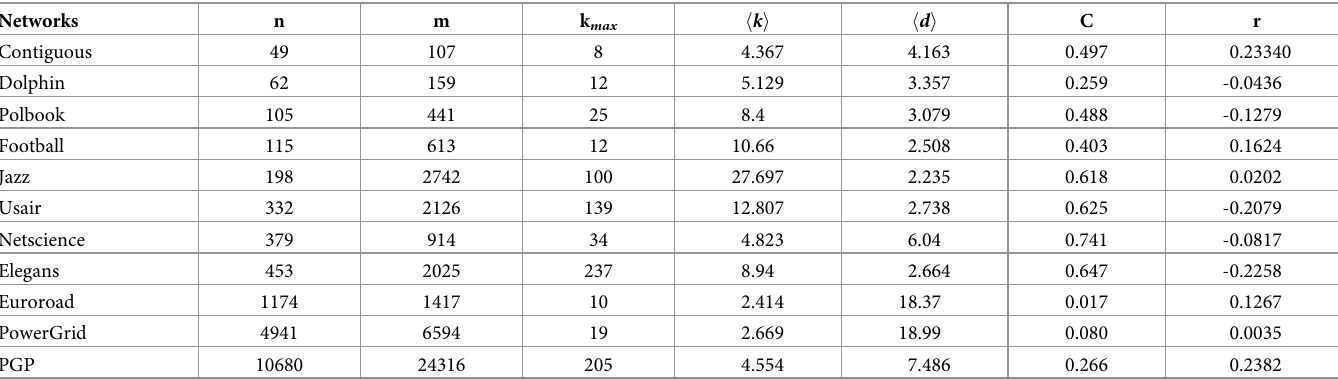
Table 1. Some statistical properties of the real networks.